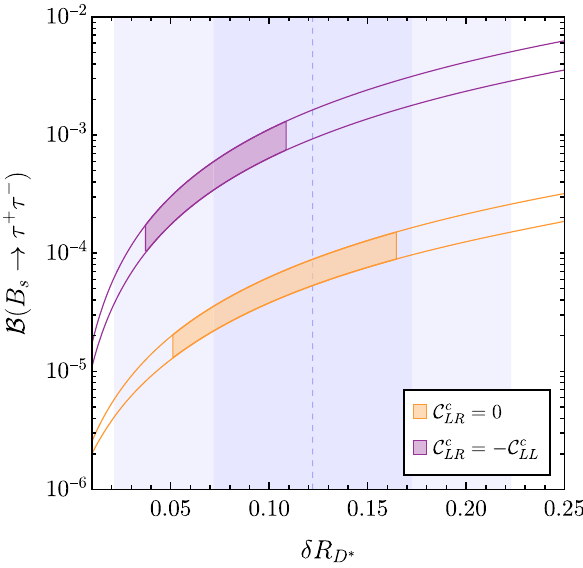
Fig. 5 Predicted range for B ( B s → τ + τ − ) as a function of δ R D ∗ = − 1. The filled orange and purple colored regions correspond R D ∗ / R SM D ∗ to the 90% CL preferred regions from the low-energy charged-current fit. The blue vertical bands denote the present 1 σ and 2 σ experimental ranges for δ R D